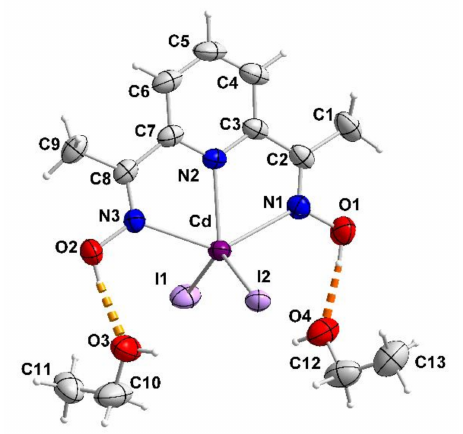
Figure 9. The molecules [CdI 2 (dapdoH 2 )] and EtOH that are present in the crystal structure of 4 · 2EtOH. The thermal ellipsoids are presented at the 50% probability level. The thick dashed orange lines indicate hydrogen bonds between the oxime groups and the lattice EtOH